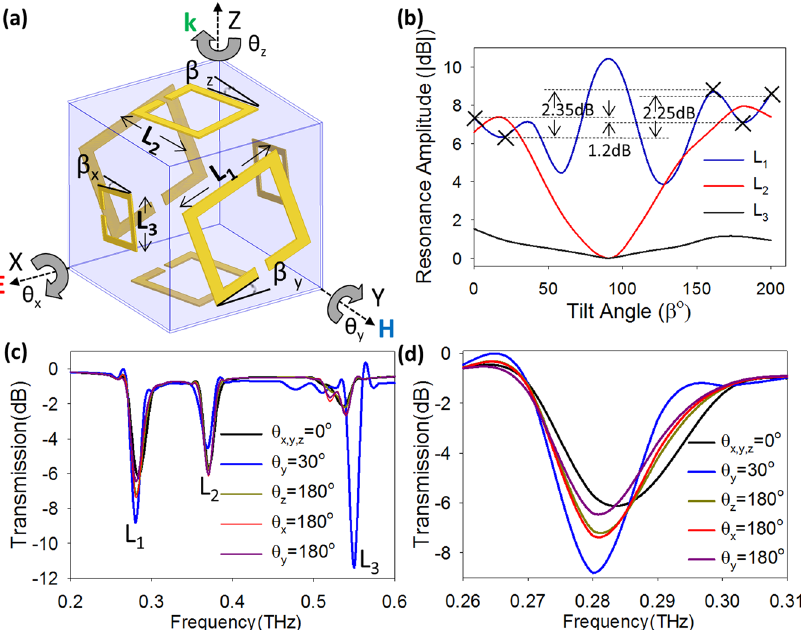
Figure 2. Effect of the angular offset on the anisotropy of the 3D inclinometer. ( a ) Cubic rotation sensor with an angular offset of β x , β y , and β z for each resonator L 3 , L 1 , and L 2 , respectively. ( b – d ) Simulation results for the cubic sensor. ( b ) The variation in the first mode resonance strength as a function of the angular offset obtained by placing only 1 of the 3 resonators at a single time to avoid couplings; L 2 and L 3 have a 180° period but the L 1 resonator has no symmetry in its transmission. ( c ) Graph showing the anisotropic effect of adding angular offset; the resonator L 1 demonstrates a significant change in amplitude for a 180° rotation about any axis. ( d ) Zoomed in graph of ( c ) showing the variance in transmission of the L 1